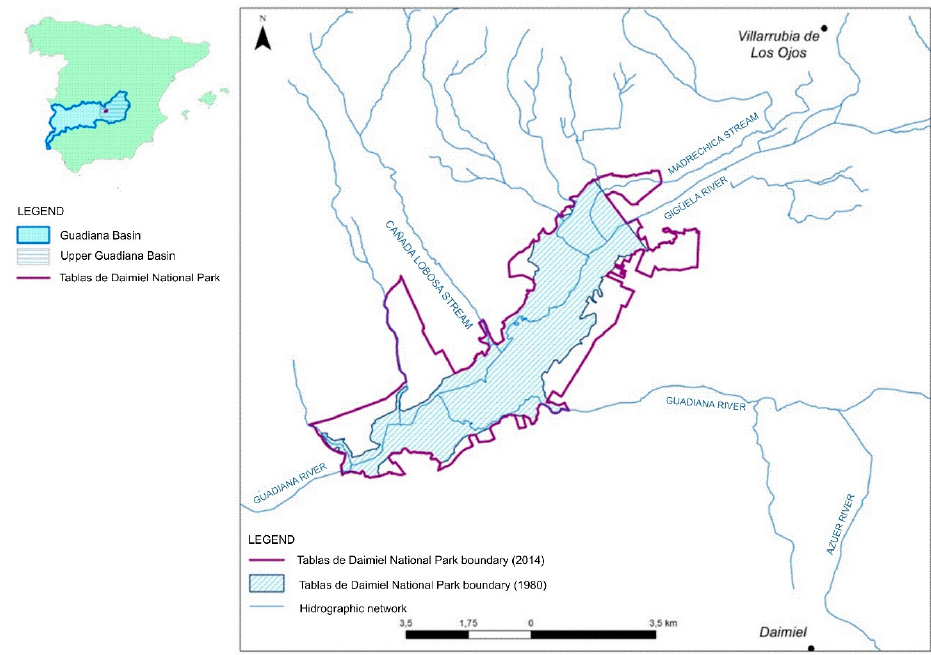
Figure 3. Boundaries of Las Tablas de Daimiel National Park and main river courses in the vicinity.